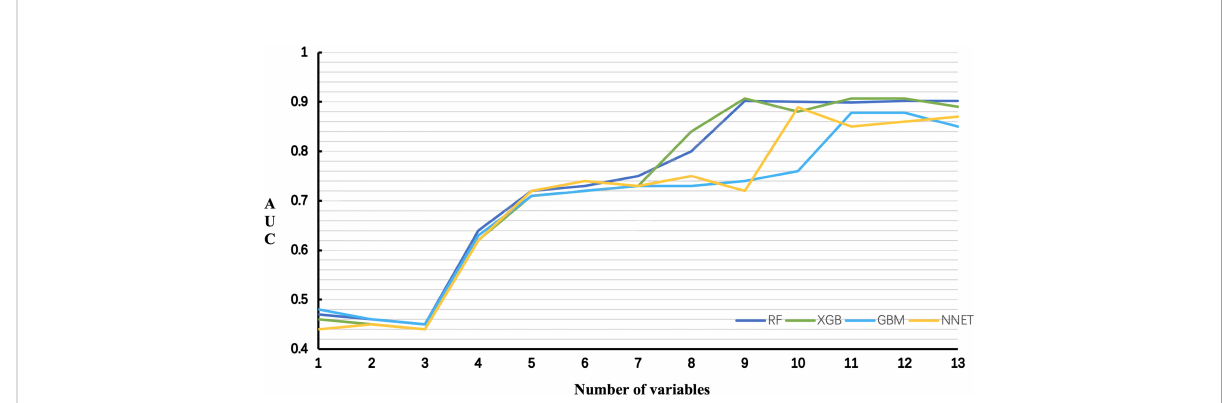
FIGURE 6 Predictive performance of the RF, XGB, GBM, NNET models with different numbers of variables. RF , Random Forest; XGB , Extreme Gradient Boosting; GBM , Gradient Boosting Machine; NNET , Neural